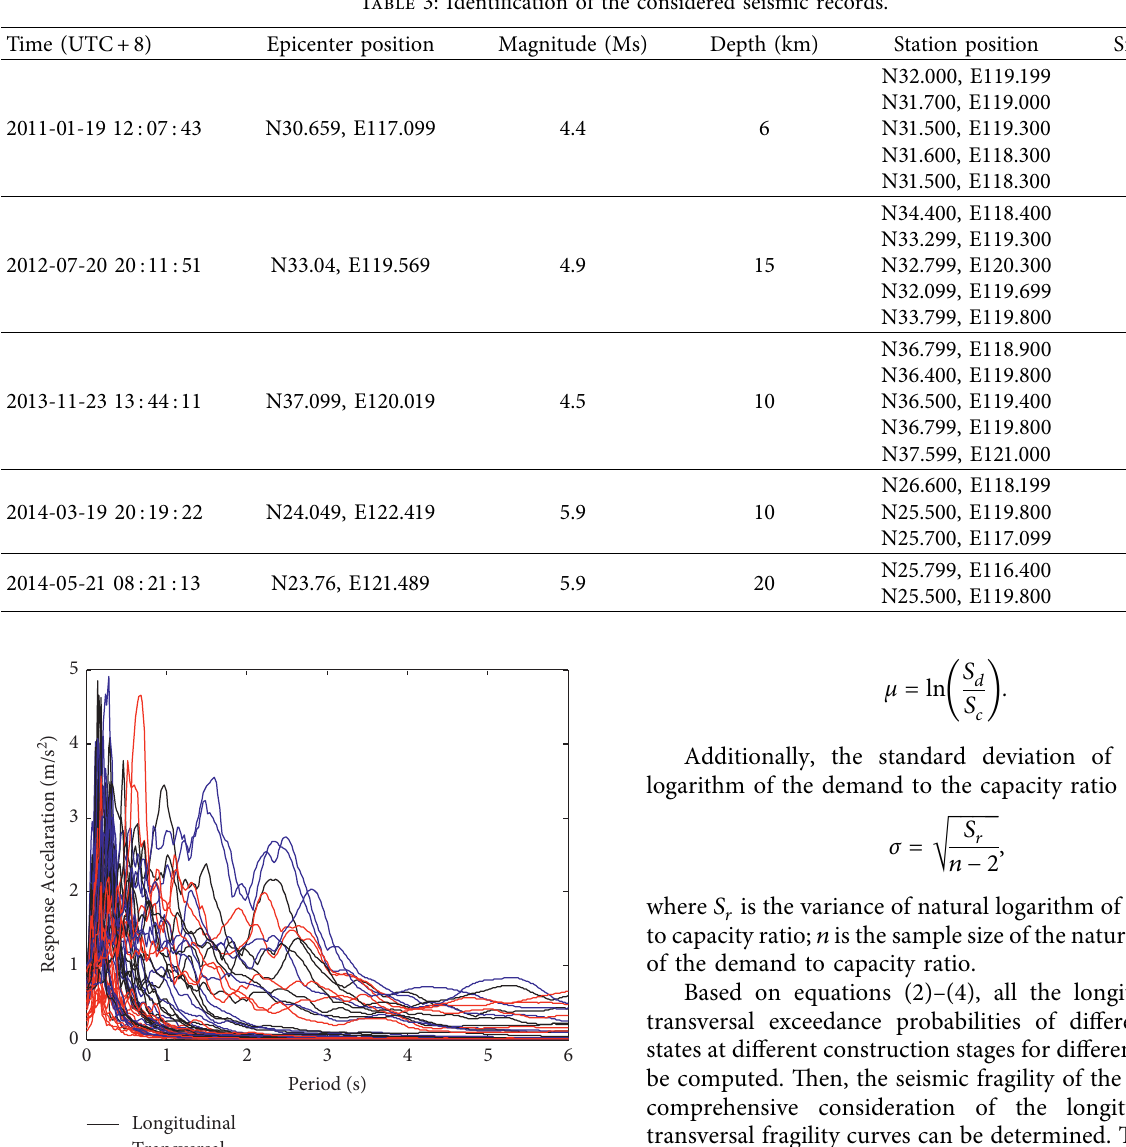
Table 3: Identification of the considered seismic records.